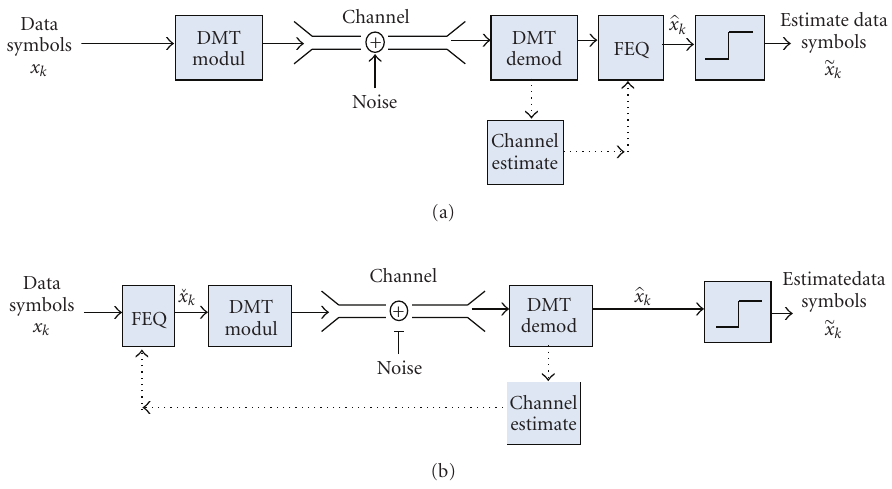
Figure 1: (a) DMT system block diagram with FEQ at receiver. (b) DMT system block diagram with FEQ at transmitter.